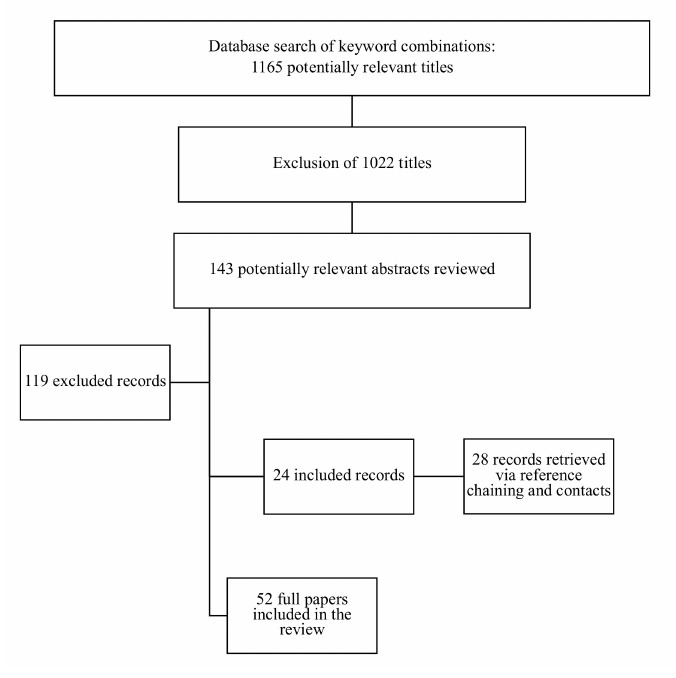
Figure 1. Study selection process. Table 1. Scientific societies’ guidelines on selection of women with endometrial cancer that are candidates for fertility sparing